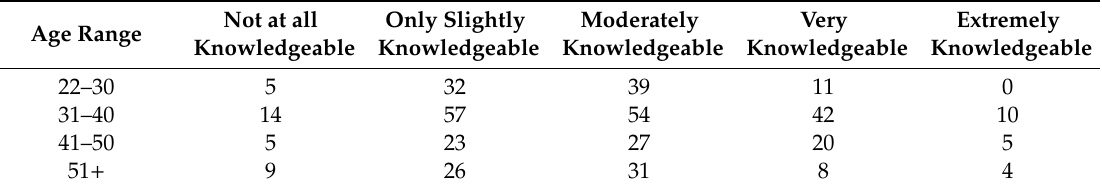
Table 8. Perceived level of knowledge regarding current rehabilitation technology for respondent clinical specialty or patient population (number of